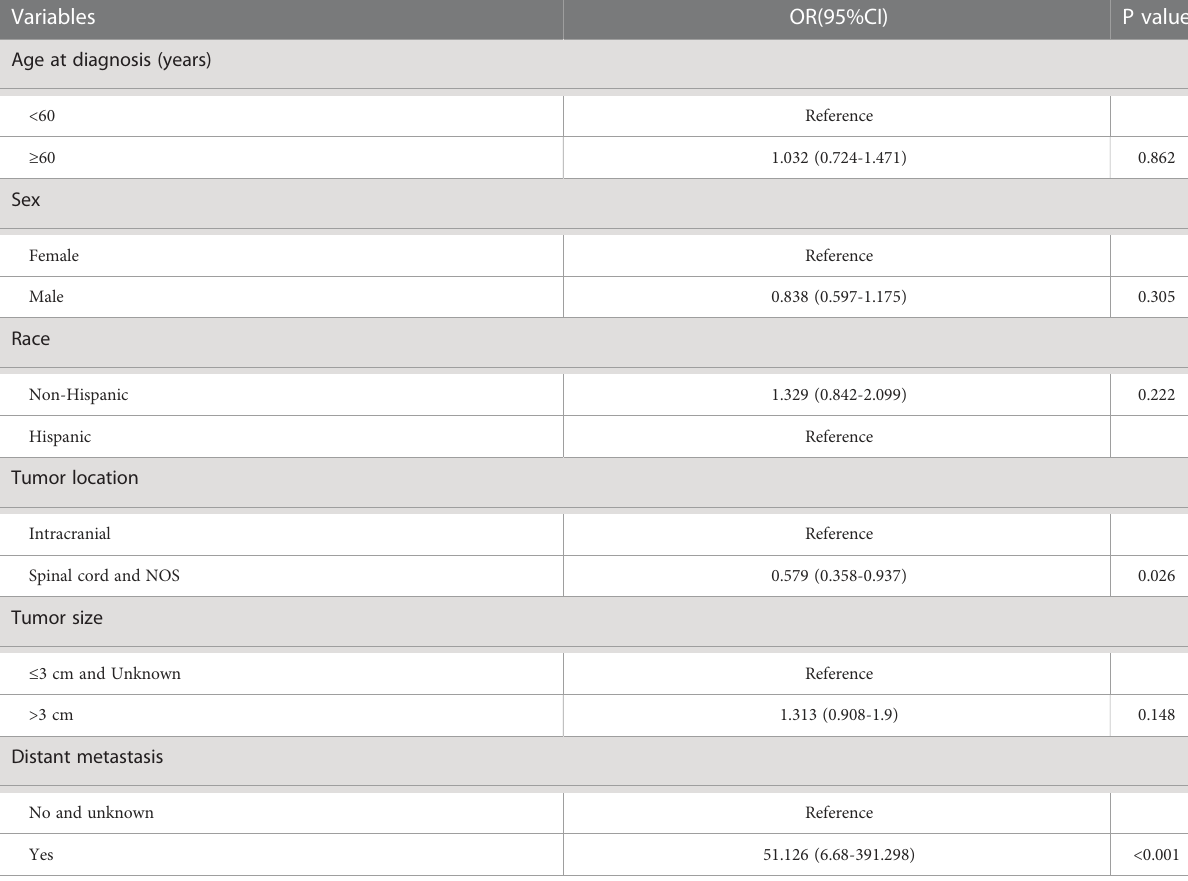
TABLE 2 Results of binary logistics